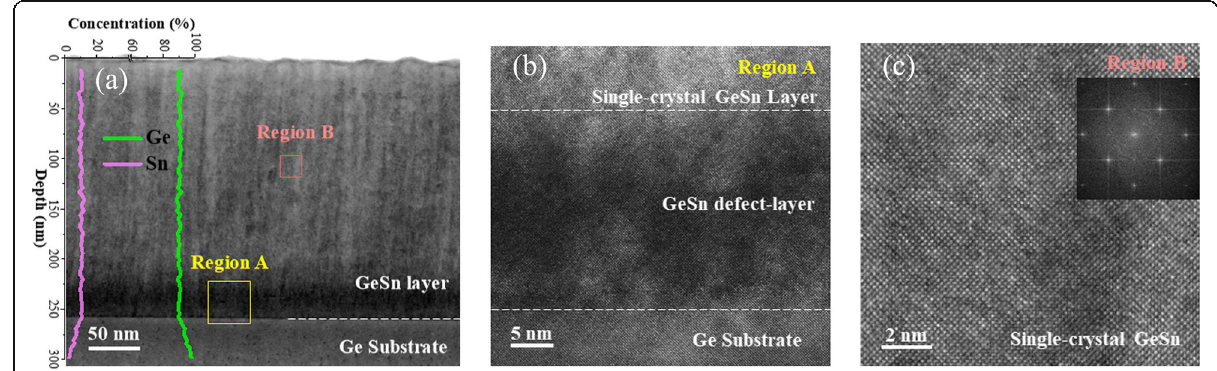
Fig. 3 a Cross-sectional TEM image of the 5 μ m diameter GeSn circular mesa without top polysilicon layer. Inset: SIMS depth profile of the GeSn layer. b High-resolution TEM image of the GeSn/Ge interface (region A). c High-resolution TEM image for the middle region of the GeSn layer (region B). Inset: FFT pattern of region